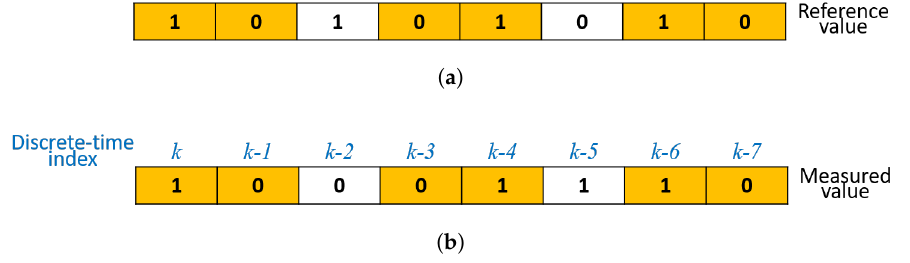
Figure 6. An illustration of a binary signal array for an 8-bit case. The orange color indicates the matching signal between the reference and the measured signals. ( a ) Reference binary signal array; ( b ) Measured binary signal